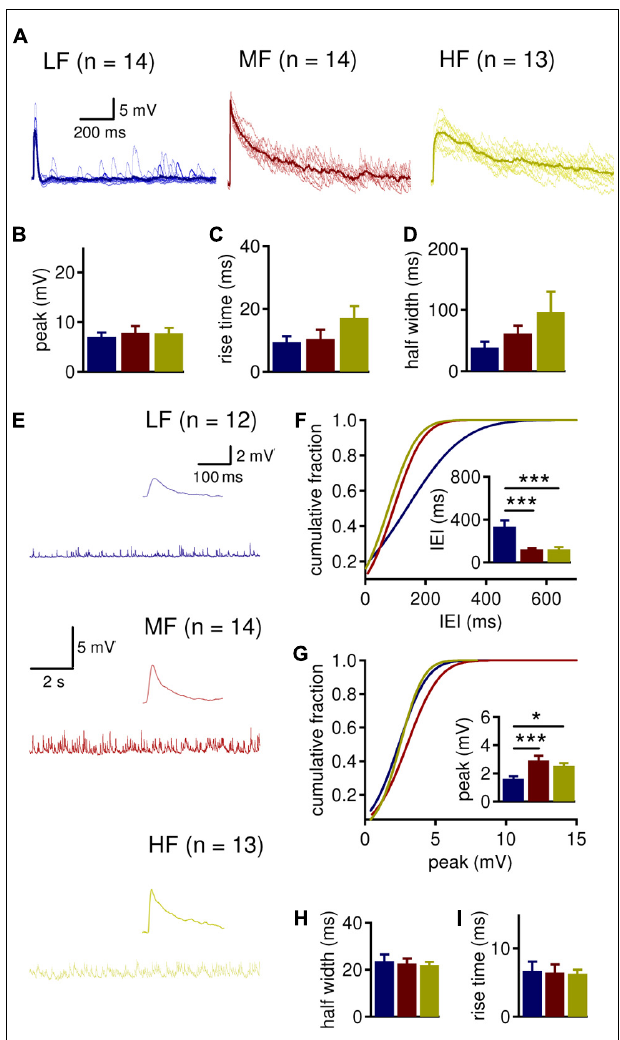
FIGURE 5 | MF and HF neurons tend to have wider IPSPs and larger sIPSPs than LF neurons. (A) Sample evoked inhibitory postsynaptic potentials (IPSP) recordings (the average traces shown as thicker lines). A square current pulse (0.2 ms) was delivered to a mixed excitatory and inhibitory fiber tract, and IPSPs were isolated in the presence of DNQX (20 μ M). QX-314 (5 mM) was present in the intracellular solution to prevent action potentials in the recorded neurons. LF (blue, n = 14) neurons tend to have more narrow IPSPs than MF (red, n = 14) and HF (yellow, n = 13) neurons. (B) Peak IPSP amplitude is not significantly different in LF (7.1 ± 0.8 mV), MF (7.8 ± 1.4 mV), and HF (7.7 ± 1.1 mV) neurons. (C) 10–90% rise time of IPSP is not significantly different in LF (9.5 ± 1.9 ms), MF (10.4 ± 3.0 ms), and HF (17.1 ± 3.8 ms) neurons. (D) The half width of IPSPs is significantly larger in HF (97.3 ± 32.8 ms) neurons compared to LF (39.0 ± 9.6 ms) neurons. MF (61.3 ± 13.0 ms) neurons do not differ from LF or HF neurons. (E) Sample spontaneous IPSP (sIPSP) recordings from LF (blue, n = 12), MF (red, n = 14), and HF (yellow, n = 13) neurons, with a sample single sIPSP shown as an inset. (F) MF (120.0 ± 11.0 ms) and HF (120.4 ± 21.4 ms) neurons have significantly shorter inter-event intervals (IEI) than LF (333.3 ± 58.9) neurons. (G) LF neurons (1.6 ± 0.2 mV) have smaller sIPSP peak amplitude than MF (3.3 ± 0.3 mV) and HF (2.5 ± 0.2 mV) neurons. (H,I) sIPSP half width and 10–90% rise time are not different between CF regions. * p < 0.05, ** p < 0.01, *** p < 0.001.